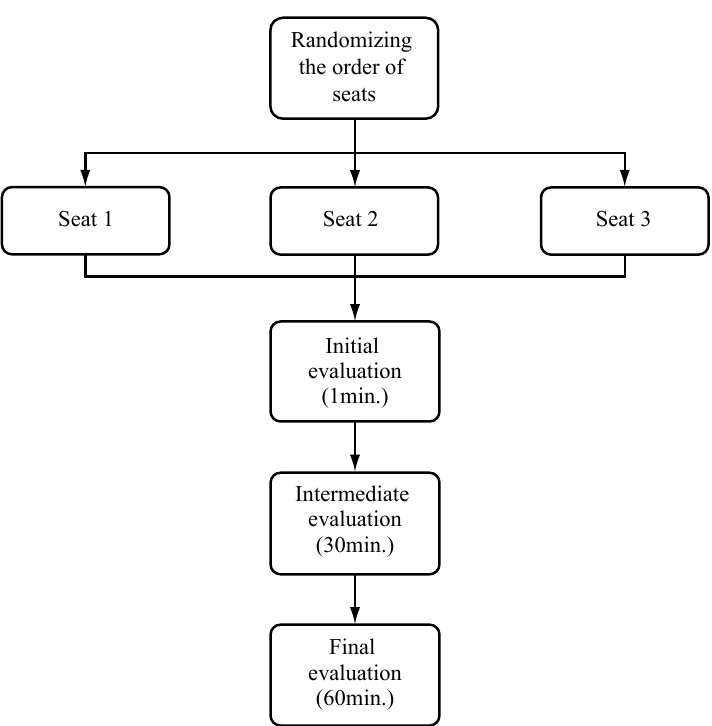
Figure 3 – Diagram illustrating the sequence of the evaluation in the